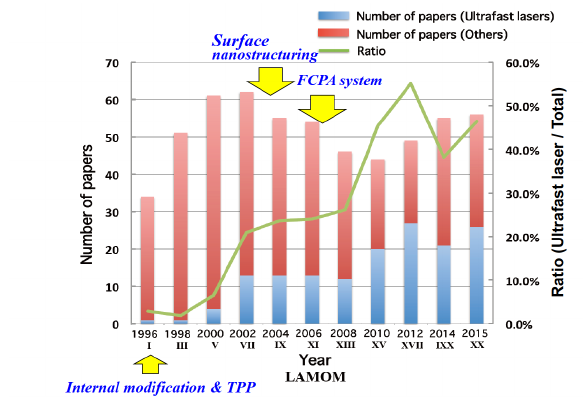
Figure 1: Evolution of the number of papers related to ultrafast laser processing presented at the SPIE LAMOM conference each year since